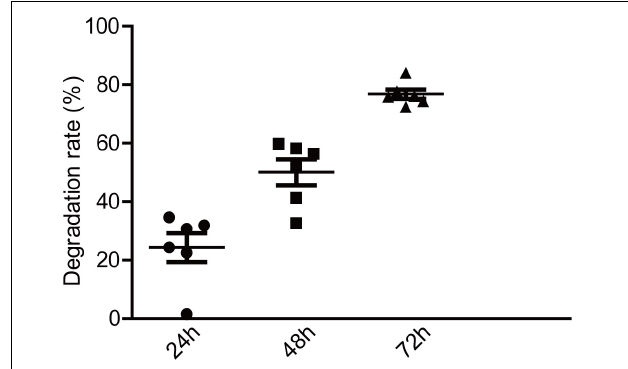
FIGURE 2 | Degradation of EPS-m2 by HGM in vitro . IntDen of each dot in TLC plates was measured using ImageJ software (https://imagej.nih.gov/ij; National Institutes of Health, Bethesda, MD, United States). The degradation rates of EPS-m2 by HGM were then